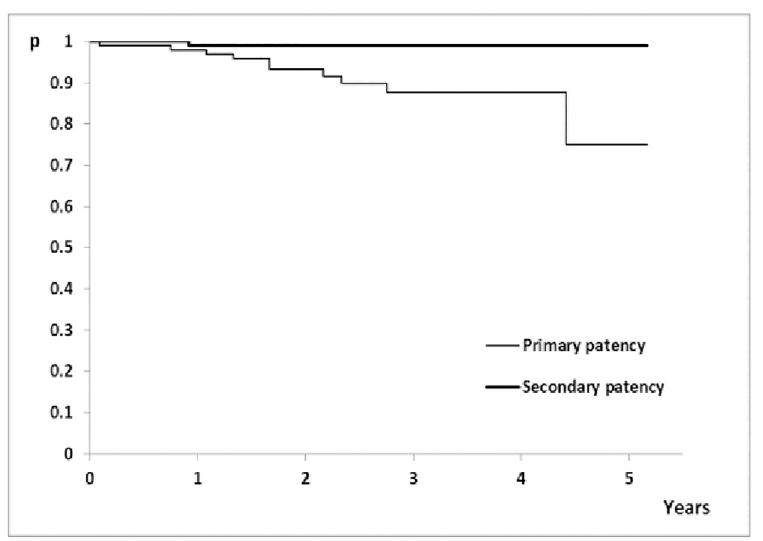
Fig 2. Kaplan-Meier primary and secondary patency rates for the whole group.